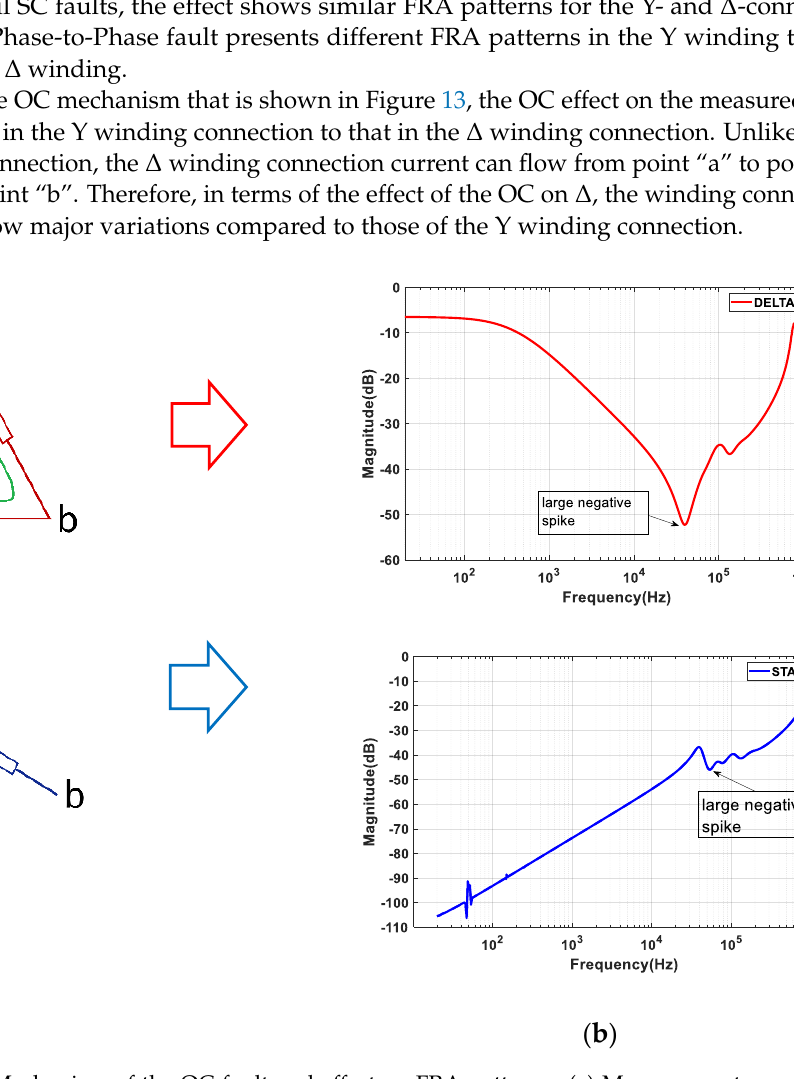
Figure 13. Mechanism of the OC fault and effect on FRA patterns. ( a ) Measurement connection. ( b ) FRA patterns.